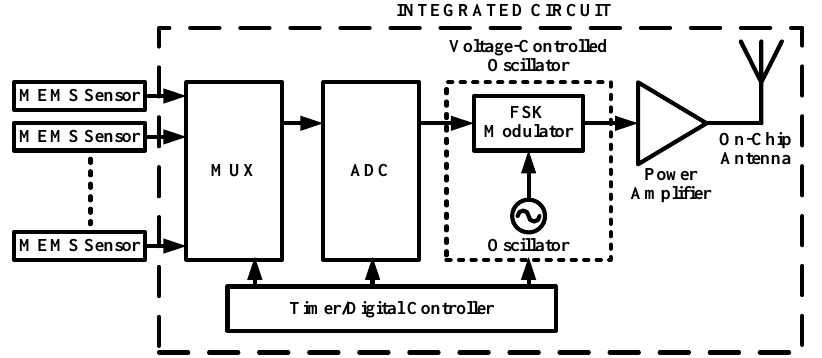
Figure 39. The new proposed system design block